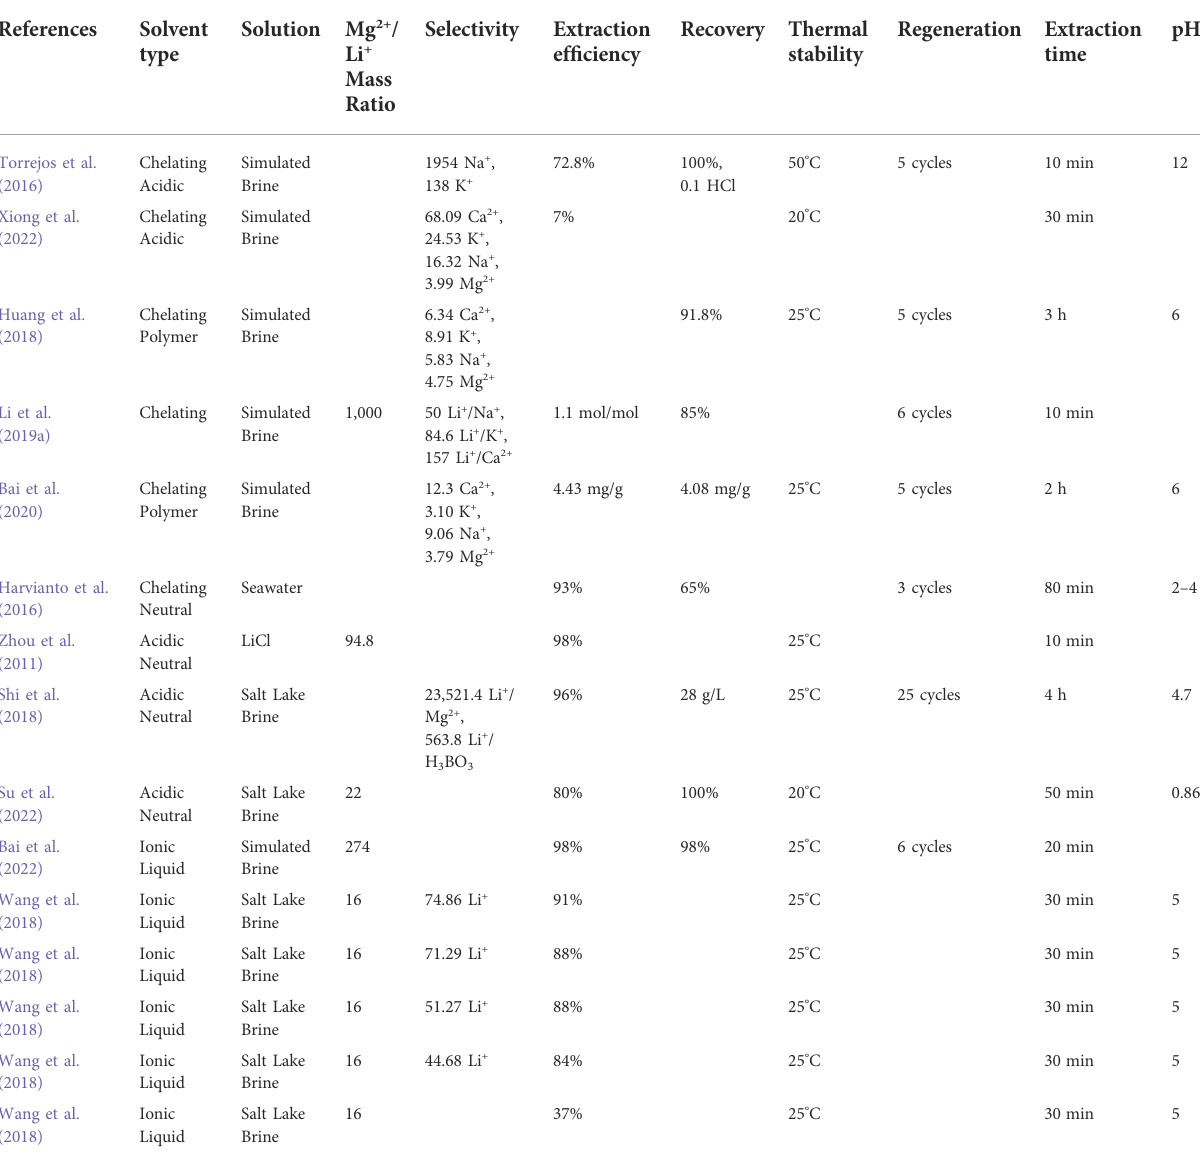
TABLE 4 Li + solvent extraction from salt lake brines, simulated brines, and